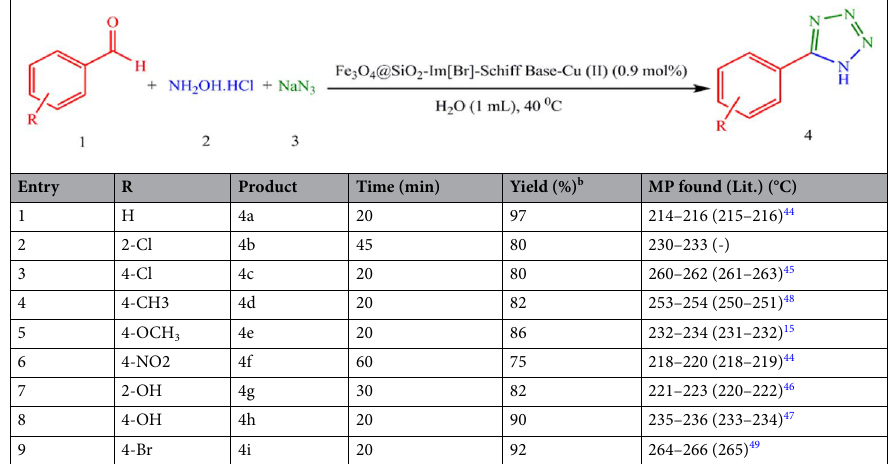
Table 4. Synthesis of 5-aryl-1 H -Tetrazole derivatives in presence of Fe 3 O 4 @SiO 2 -Im[Br]-SB-Cu (II) catalyst a . a Reaction conditions: Benzaldehyde (1.0 mmol), hydroxy amine hydrochloride (1.0 mmol), Sodium azide